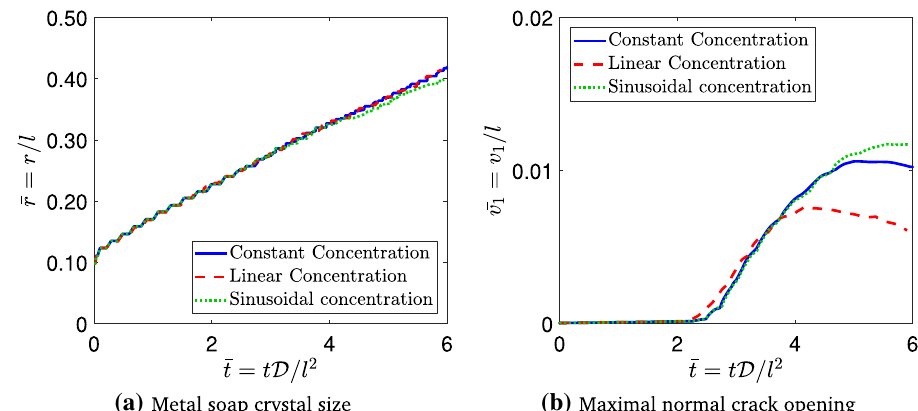
Fig. 7 Influence of the pre- scribed saturated fatty acid concentration on the time evolution of a the metal soap crystal size ̄ r (with ̄ r being the average radius of the crystal) and b the maximal normal crack opening ̄ v 1 of the most predominant